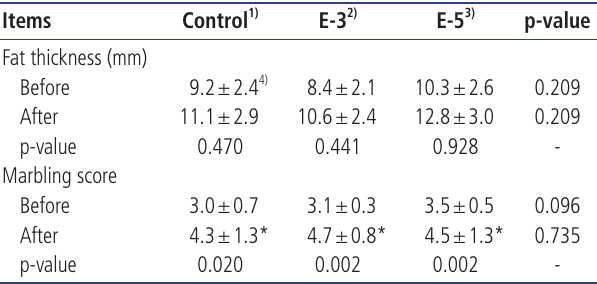
Table 4. Fat thickness and marbling score of finishing Korean cattle (Hanwoo) steers measured by ultrasound scanner before and after feeding